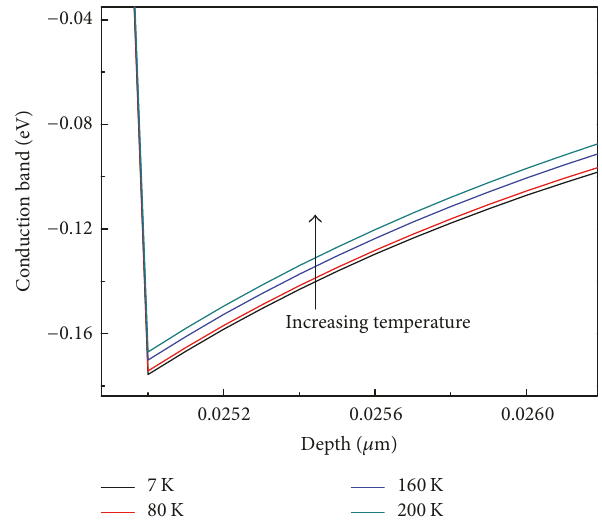
Figure 3: The conduction band profile of the AlGaN/GaN interface for different